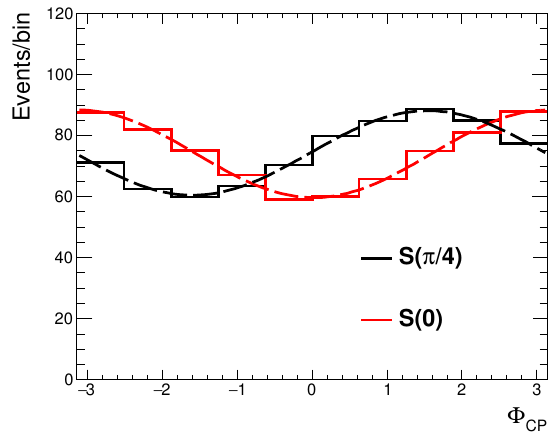
Figure 2 . Normalized di(cid:11)erential distribution of (cid:8) CP for the h + (cid:21) 2 (cid:0) jets process at 14 TeV LHC, with (cid:1) = (cid:25)= 4, for three di(cid:11)erent choices of the electromagnetic calorimeter granularity. The blue dashed, red dot-dashed and the black solid histograms correspond to an ECAL granularity of 0 : 0125 (cid:2) 0 : 0125, 0 : 025 (cid:2) 0 : 025 and 0 : 05 (cid:2) 0 : 05 respectively, in the (cid:17) (cid:2) (cid:30) plane.